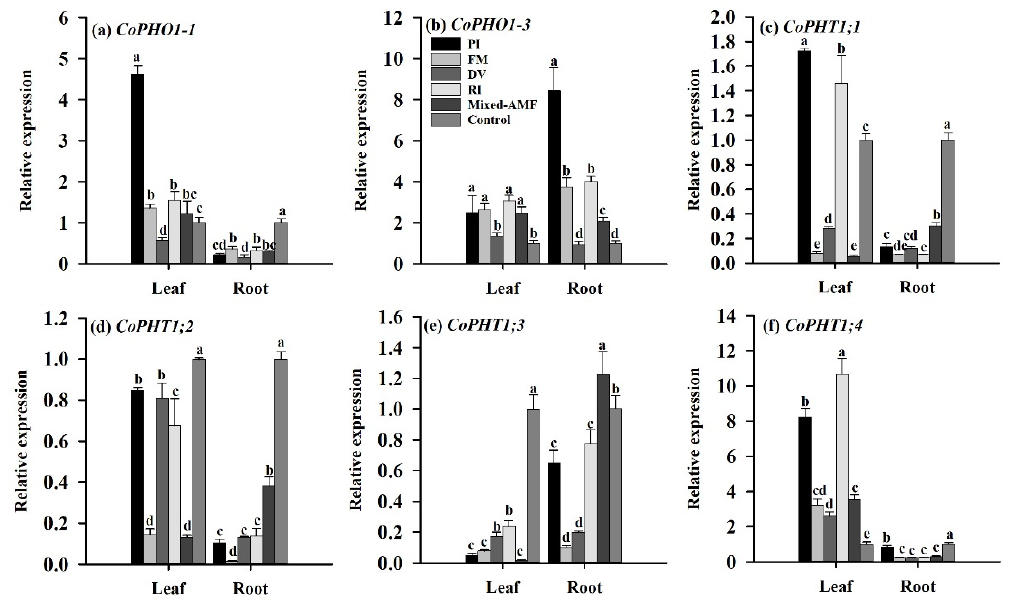
Figure 6. Effects of symbiotic fungi on expressions of CoPHO1-1 ( a ), CoPHO1-3 ( b ), CoPHT1;1 ( c ), CoPHT1;2 ( d ), CoPHT1;3 ( e ), and CoPHT1;4 ( f ) genes in leaves and roots of Camellia oleifera plants. Data (means ± SD, n = 3) followed by different letters above the bars indicate significant ( p < 0.05) differences. The abbreviation is the same as Figure 1.